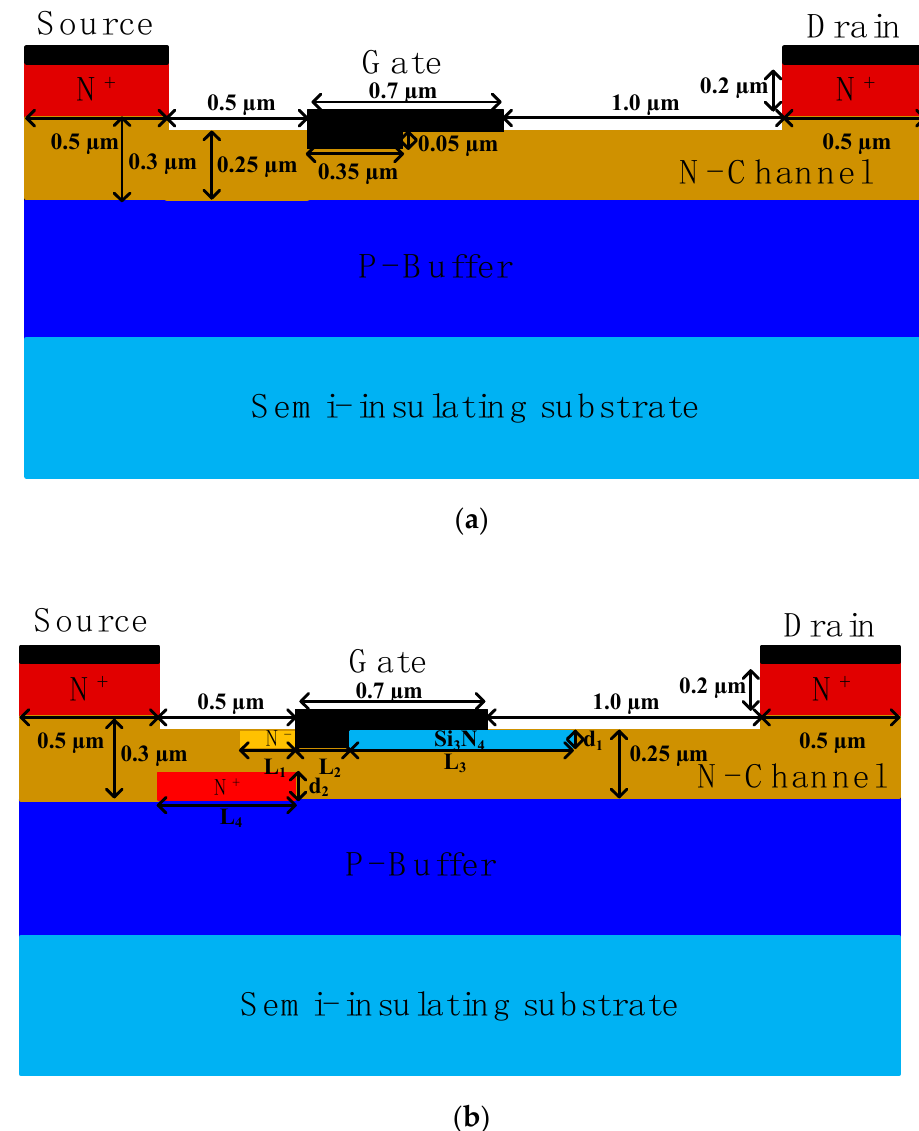
Figure 1. Cross ‐ sectional diagrams of ( a ) the DR structure and ( b ) the proposed structure. Figure 1. Cross-sectional diagrams of ( a ) the DR structure and ( b ) the proposed